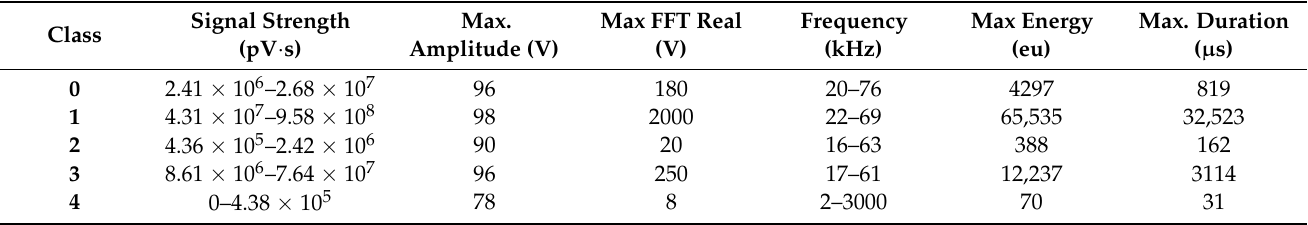
Figure 14. Chart of acoustic emission signal classes over time for the energy parameter: ( a ) point chart, ( b ) cumulative chart. Table 2. Ranges of the change of AE signal characteristics for respective clustering